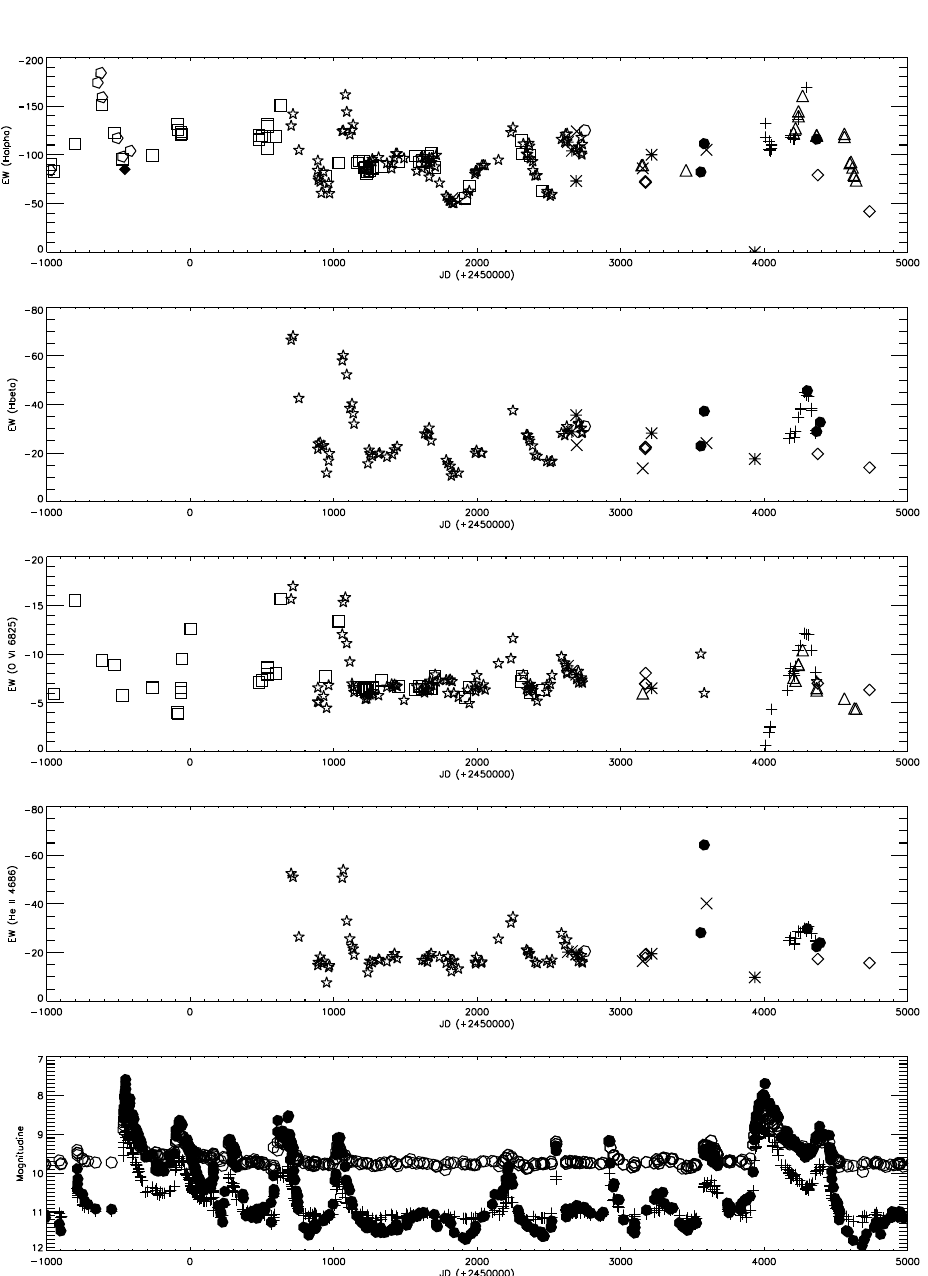
Fig. 3. The long-term spectroscopic history of AG Dra. Equivalent width variations of (top to bottom) H α , H β , O VI Raman 6825 ˚Aand He II 4686 ˚A emission lines, corrected for continuum variations, together with the UBV